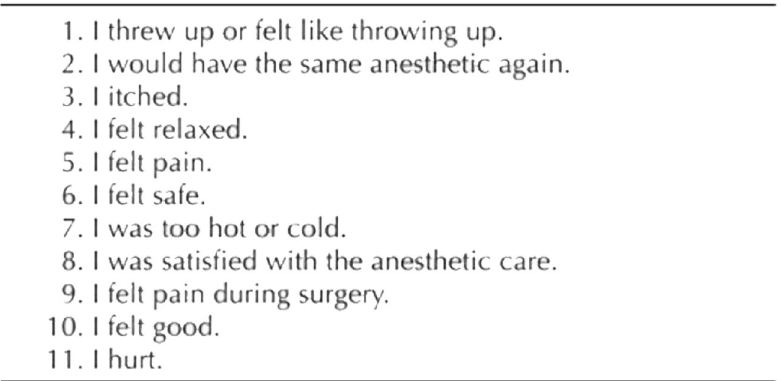
Figure 2. ISAS, Iowa Satisfaction with Anaesthesia Scale 15 (copyrighted by Franklin Dexter and the University of Iowa Research Foundation). For items 1, 3, 5, 7, 9, and 11, the scores are calculated as follows: + 6, agree very much; + 5, agree moderately; + 4, agree slightly; + 3, disagree slightly; + 2, disagree moderately; + 1, disagree very much. For items 2, 4, 6, 8, and 10, the scores are calculated in the reverse order from the aforementioned items.